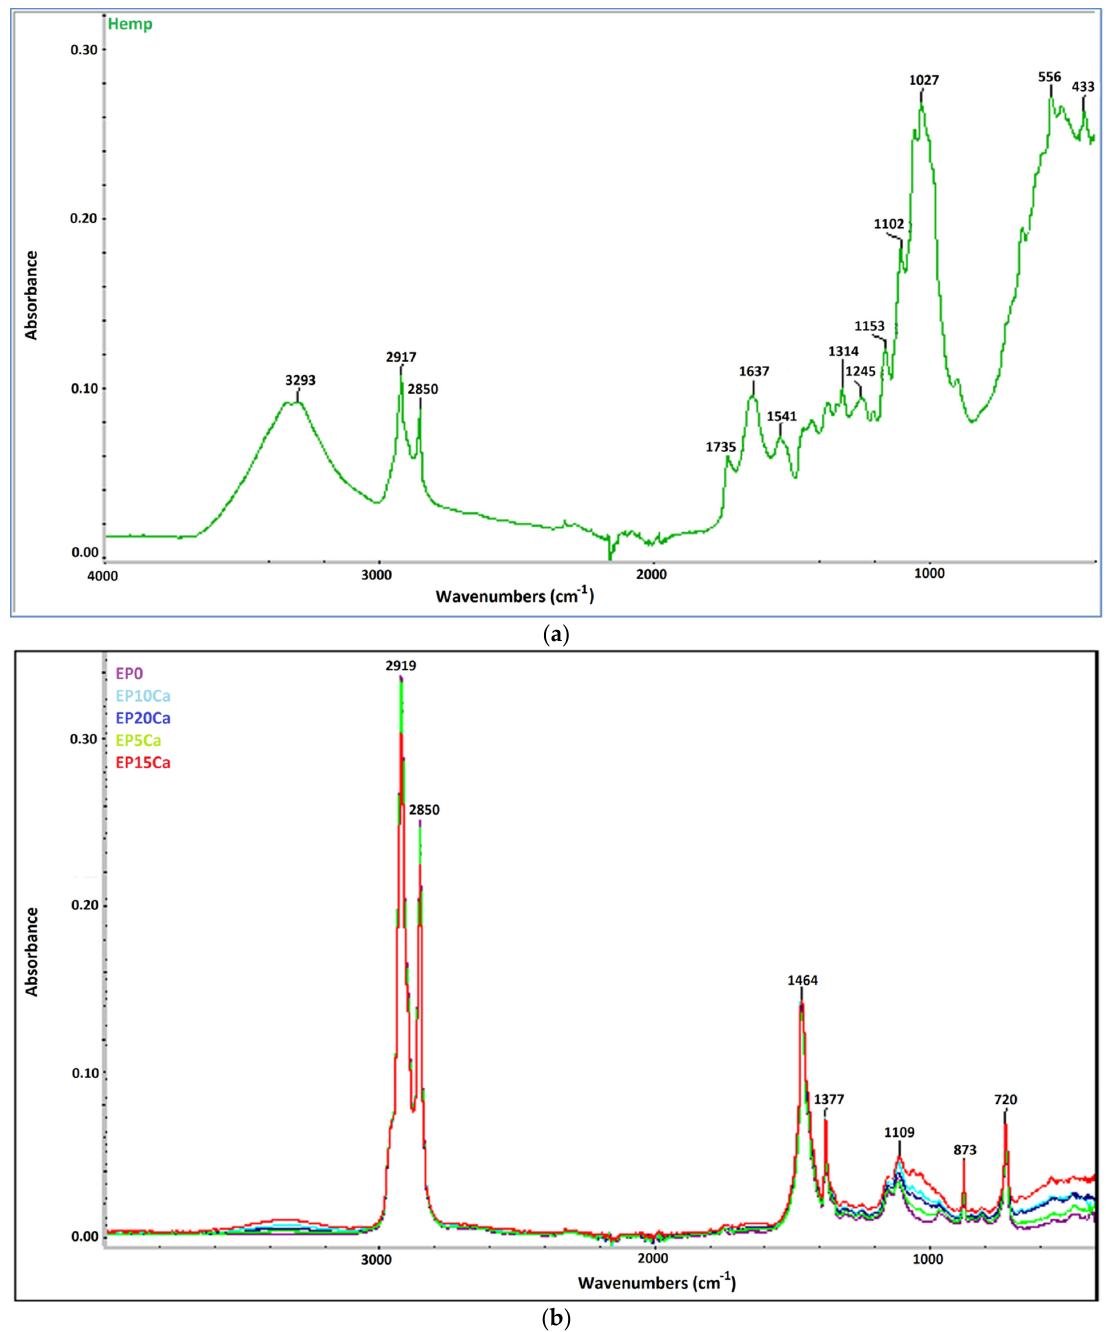
Figure 5. FTIR spectra of ( a ) hemp fiber; ( b ) EPDM/hemp fiber